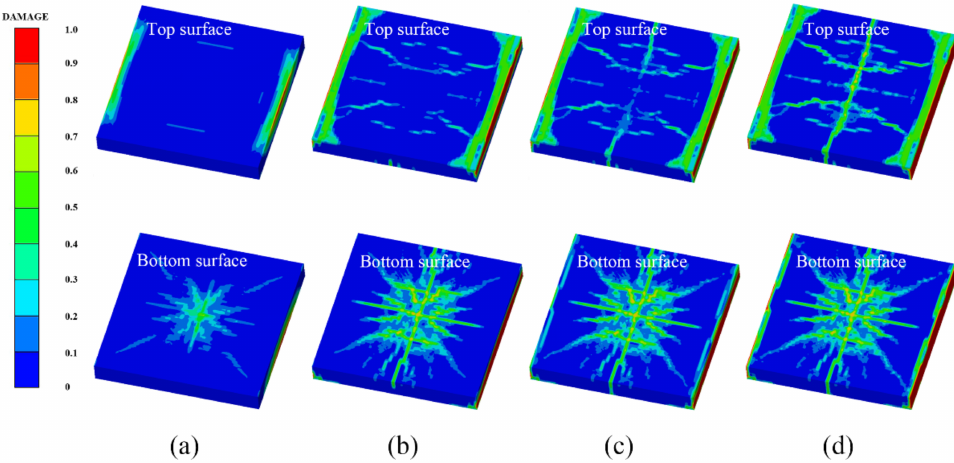
Figure 19. Damage process of the ALE coupling model: ( a ) 0.3 ms, ( b ) 0.9 ms, ( c ) 1.2 ms, ( d ) 2.0 ms.